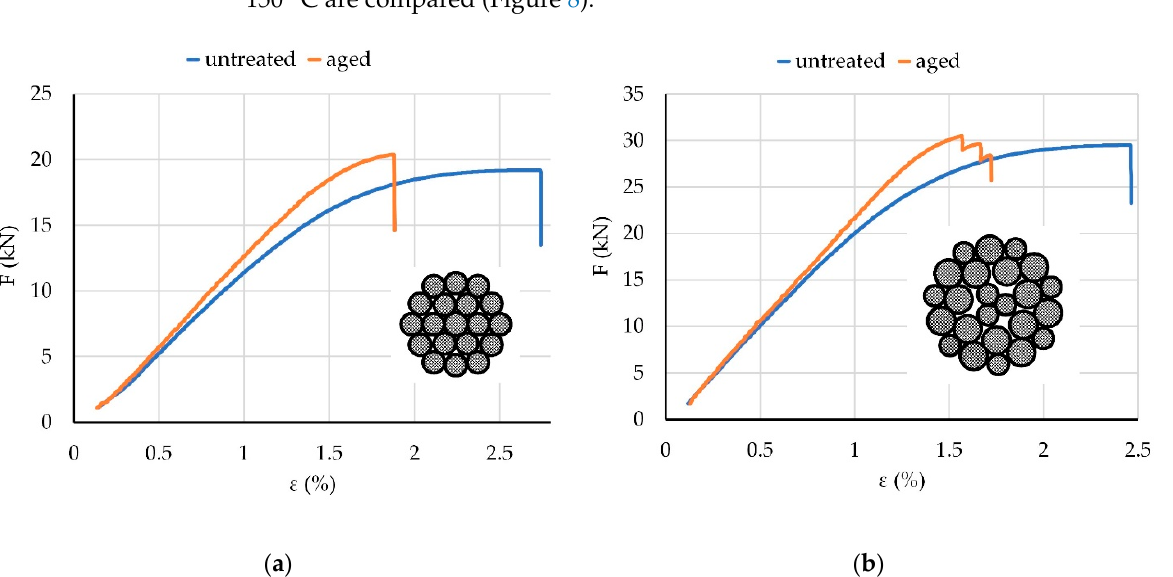
Figure 7. Histograms of ( a ) total strain at break and ( b ) plastic strain at break for Ø3.6C compact steel cord in untreated and 150 °C/45 min aged conditions.